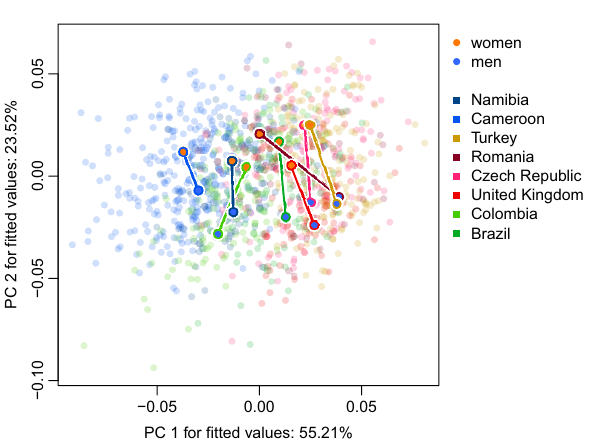
Figure 2. The results of trajectory analysis on the first two principal components. PC1 captures mostly the variation between national samples with European samples on the right and African samples on the left, while PC2 allows faces to align along sexual dimorphism axis. Both differences in direction and magnitude contribute to differences in face shape sexual dimorphism in our